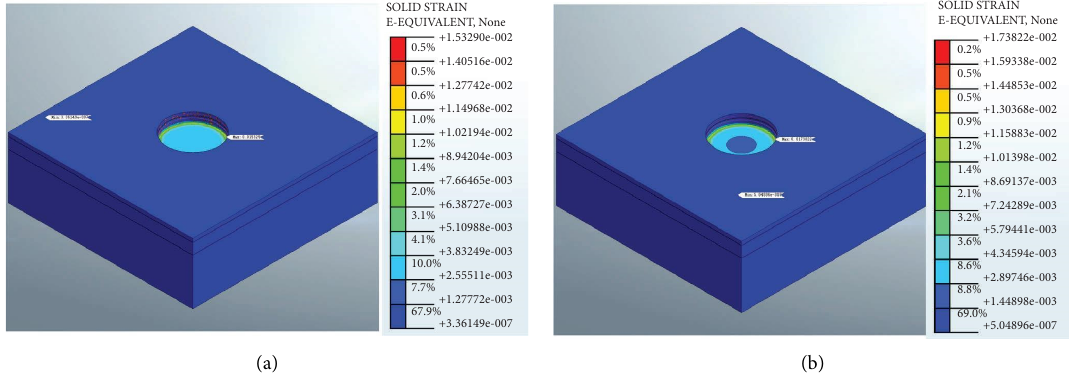
Figure 14: Working condition 5. Equivalent soil strain (a) without pore water pressure and (b) with pore water pressure applied.